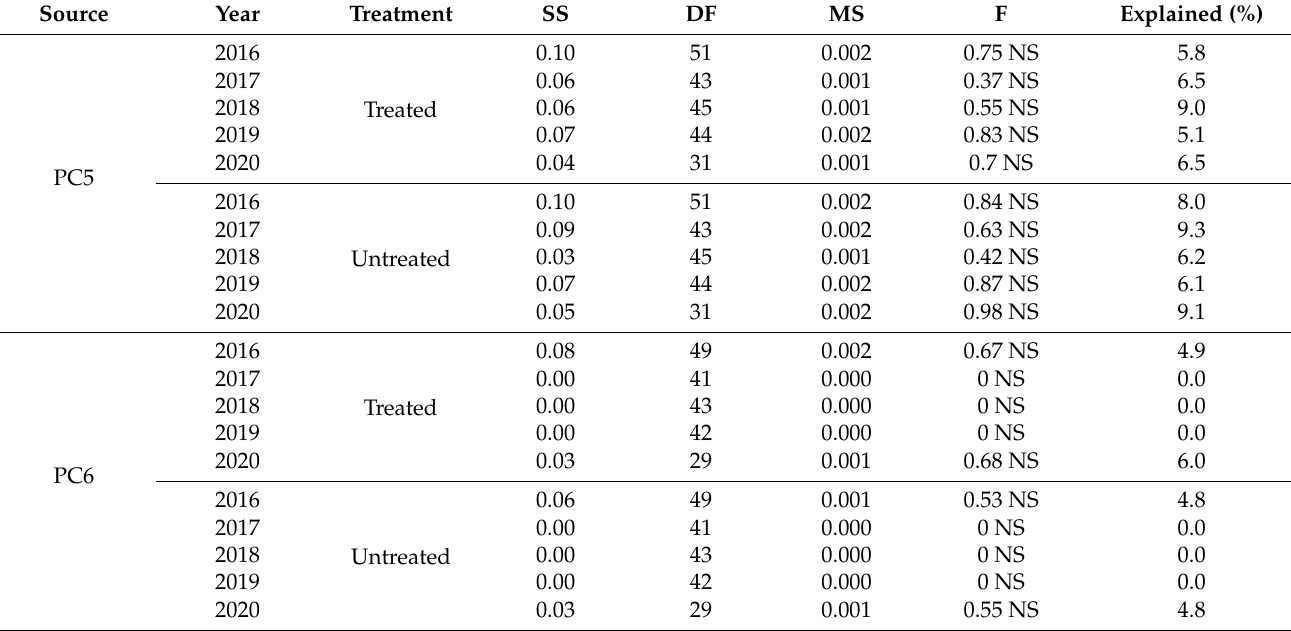
(Figure 4A). Under fungicide-treated conditions, E7-E5-E2 in Y1, E3-E5-E6 in Y2, E4-E3-E6- E5 in Y3, E6-E4-E5 in Y4 and E3-E6-E5 in Y5 were highly discriminative (Figure 4B). The average environmental axis (AEA) of the GGE Biplot designated the most representative environment to be E3 in Y1, E3-E6 in Y2, E1-E5 in Y3, E1-E3-E4-E5 in Y4 and E7-E4 in Y5 under untreated conditions (Figure 4A). Under fungicide-treated conditions, E4-E5-E2 in environments (Figure